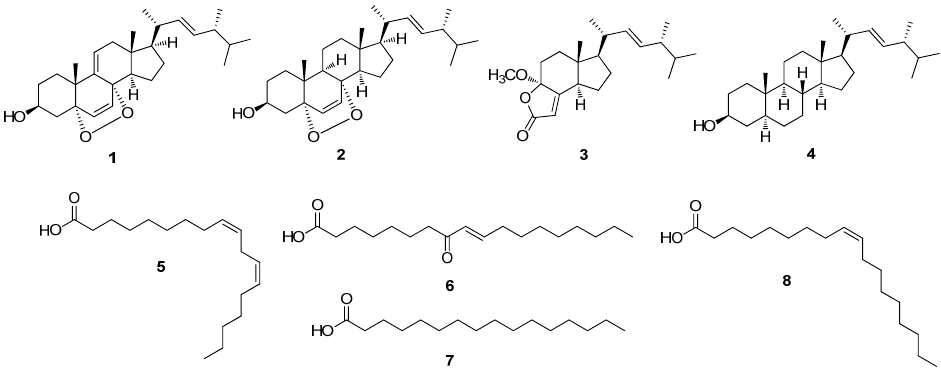
Figure 4. Chemical structures of compounds 1 – 8 ; 9,11-dehydroergosterol peroxide ( 1 ), ergosterol peroxide ( 2 ), (17 R )-17-methylincisterol ( 3 ), (3 β ,5 α ,22 E )-ergost-22-en-3-ol ( 4 ), ( Z , Z )-9,12-octadecadienoic acid ( 5 ), (9 E )-8-oxo-9-octadecenoic acid ( 6 ), hexadecanoic acid ( 7 ), and (9 Z )-9-octadecenoic acid ( 8 ).